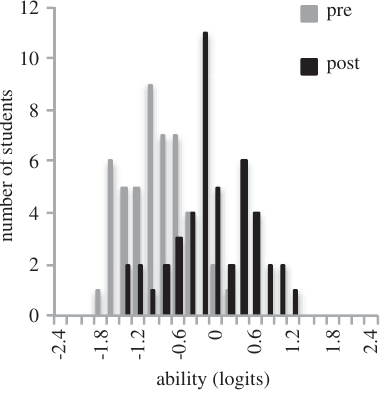
FIG. 11. Average Δ θ versus IAS for classes with at least 25 students in the LSCI national data set. FIG. 13. The pre- and postability histograms for class